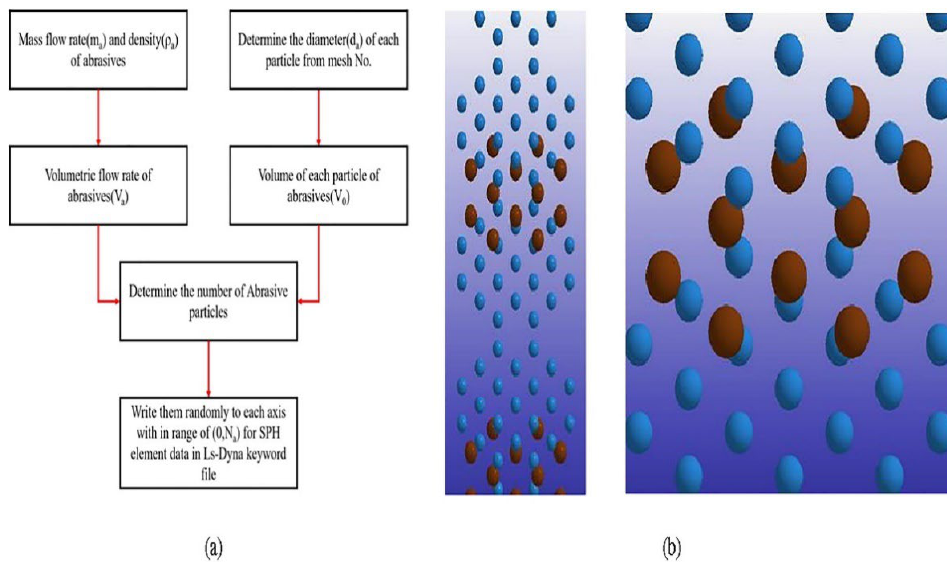
Figure 25. ( a ) Process of determining the random number of abrasive particles; ( b ) SPH modeling of water and abrasive particles [164].